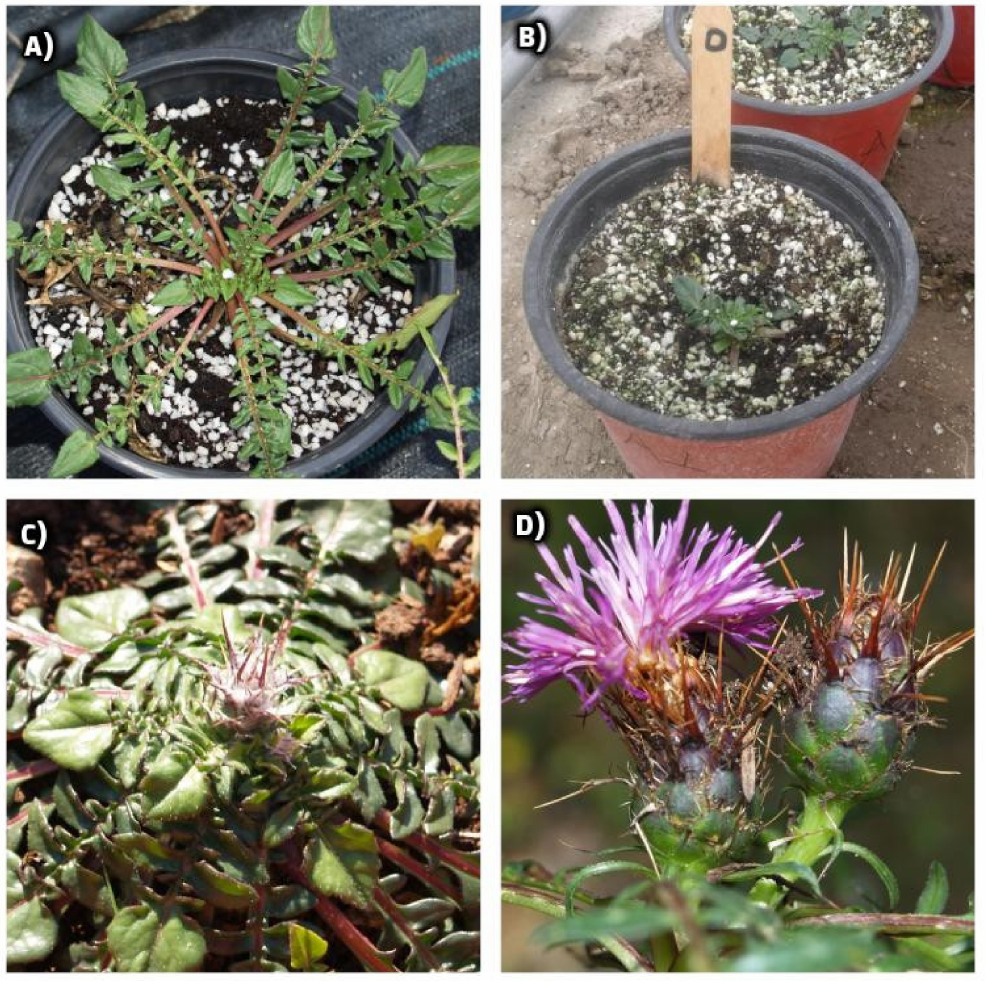
Figure 1. The various developmental phases of Centaurea raphanina : ( A ) plant before the first harvest; ( B ) plant after the first harvest; ( C ) plant before the second harvest and when the flower initiation occurred; and ( D ) plants at the flowering stage (full blossom). Photo credits: Spyridon A.